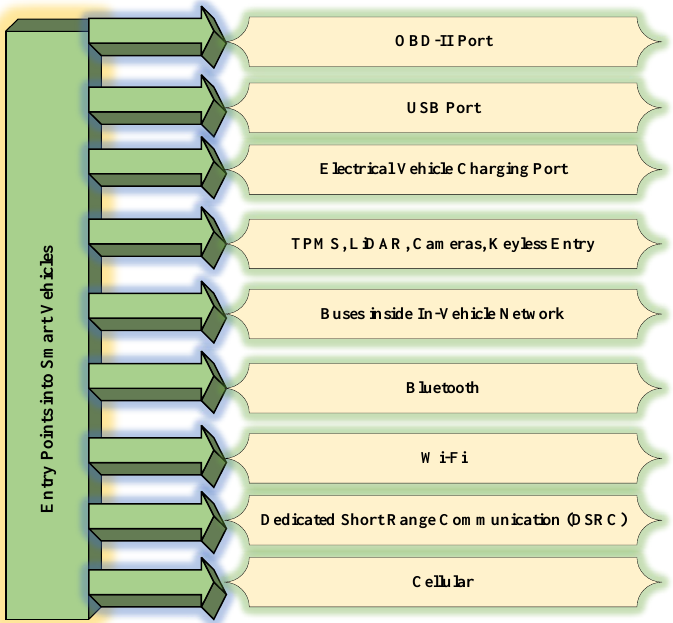
Figure 8. Illustrating entry points to smart intelligent vehicles.